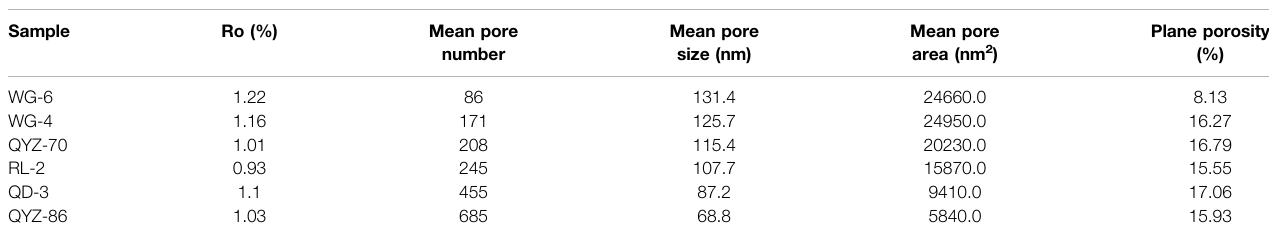
TABLE 2 | Nanopore structural parameters of coal